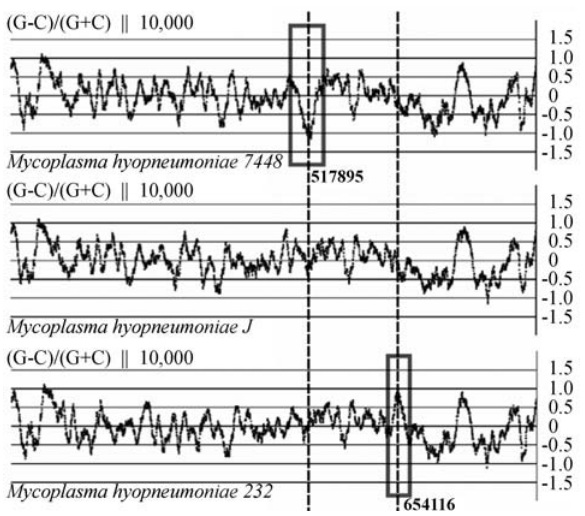
Figure 1 - GC% Skew graph showing the differential regions between the strains 7448, J and 232 of Mycoplasma hyopneumoniae . The dotted lines indicate the position of the ICEH7448 and ICEH232, respectively.